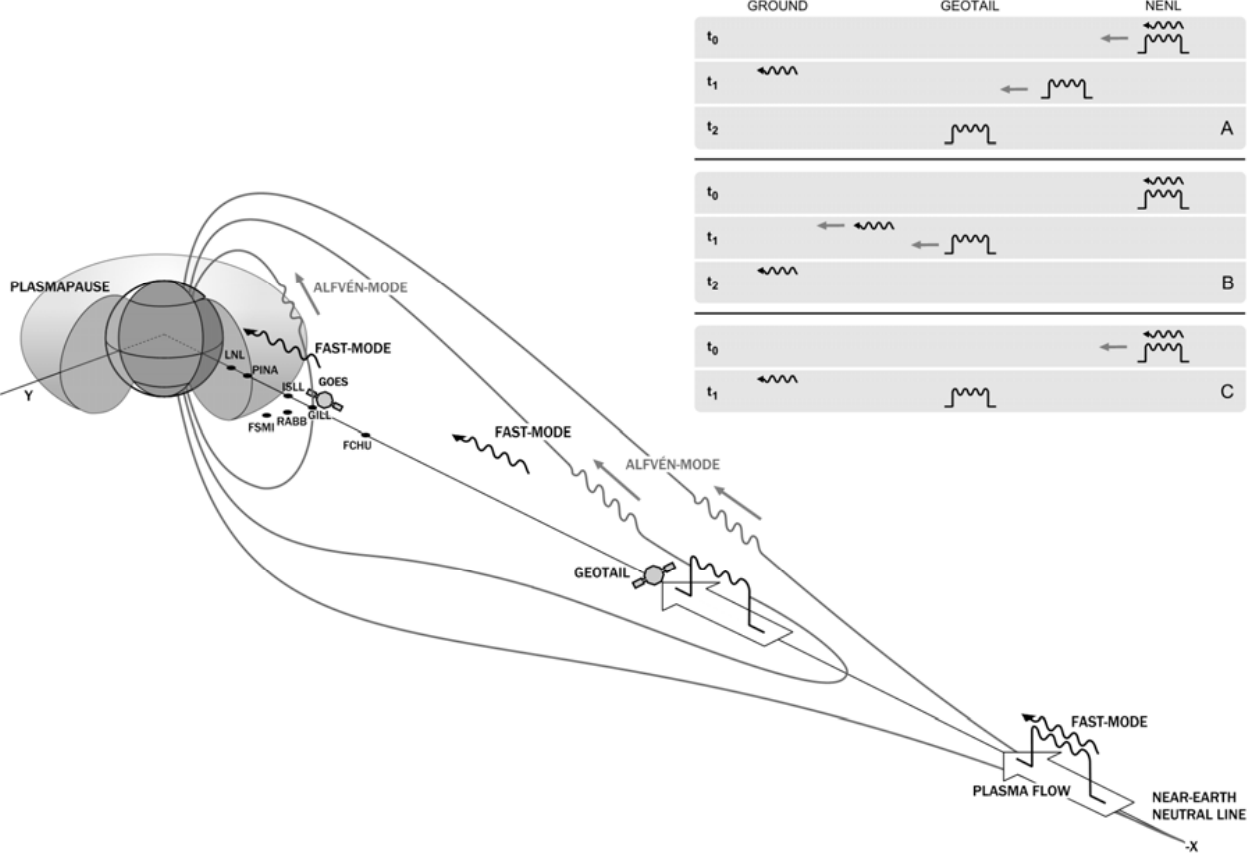
Fig. 8. An illustration depicting a potential sequence of events subsequent to reconnection at the NENL. Reconnection at the NENL results in the release of a BBF, and the production of an earthward propagating fast-mode which couples to the background field generating Pi2 pulsations observed on the ground. The inset panels (a) – (c) show three possible time lines, for t 0 → t 1 → t 2 of the relative times of observing a Pi2 pulsation on the ground and the in-situ observation of a BBF in the CPS. See text for